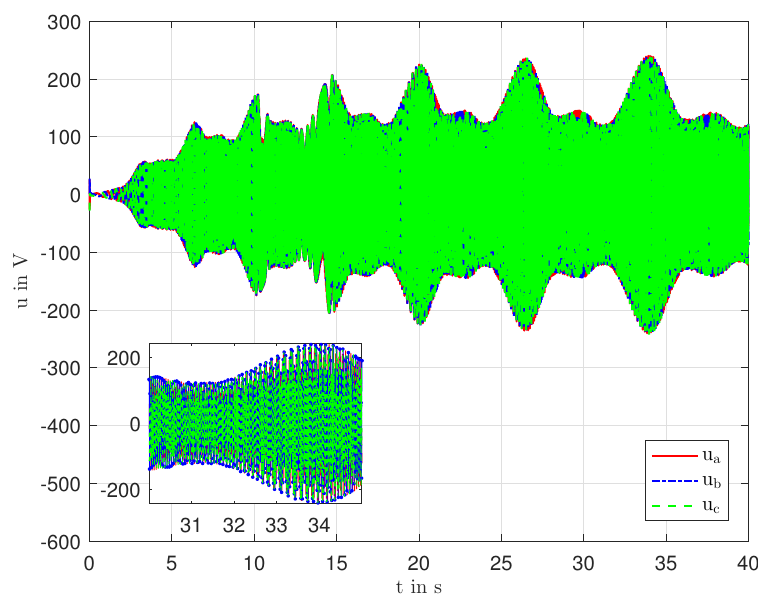
Figure 12. Three-phase control voltages of the